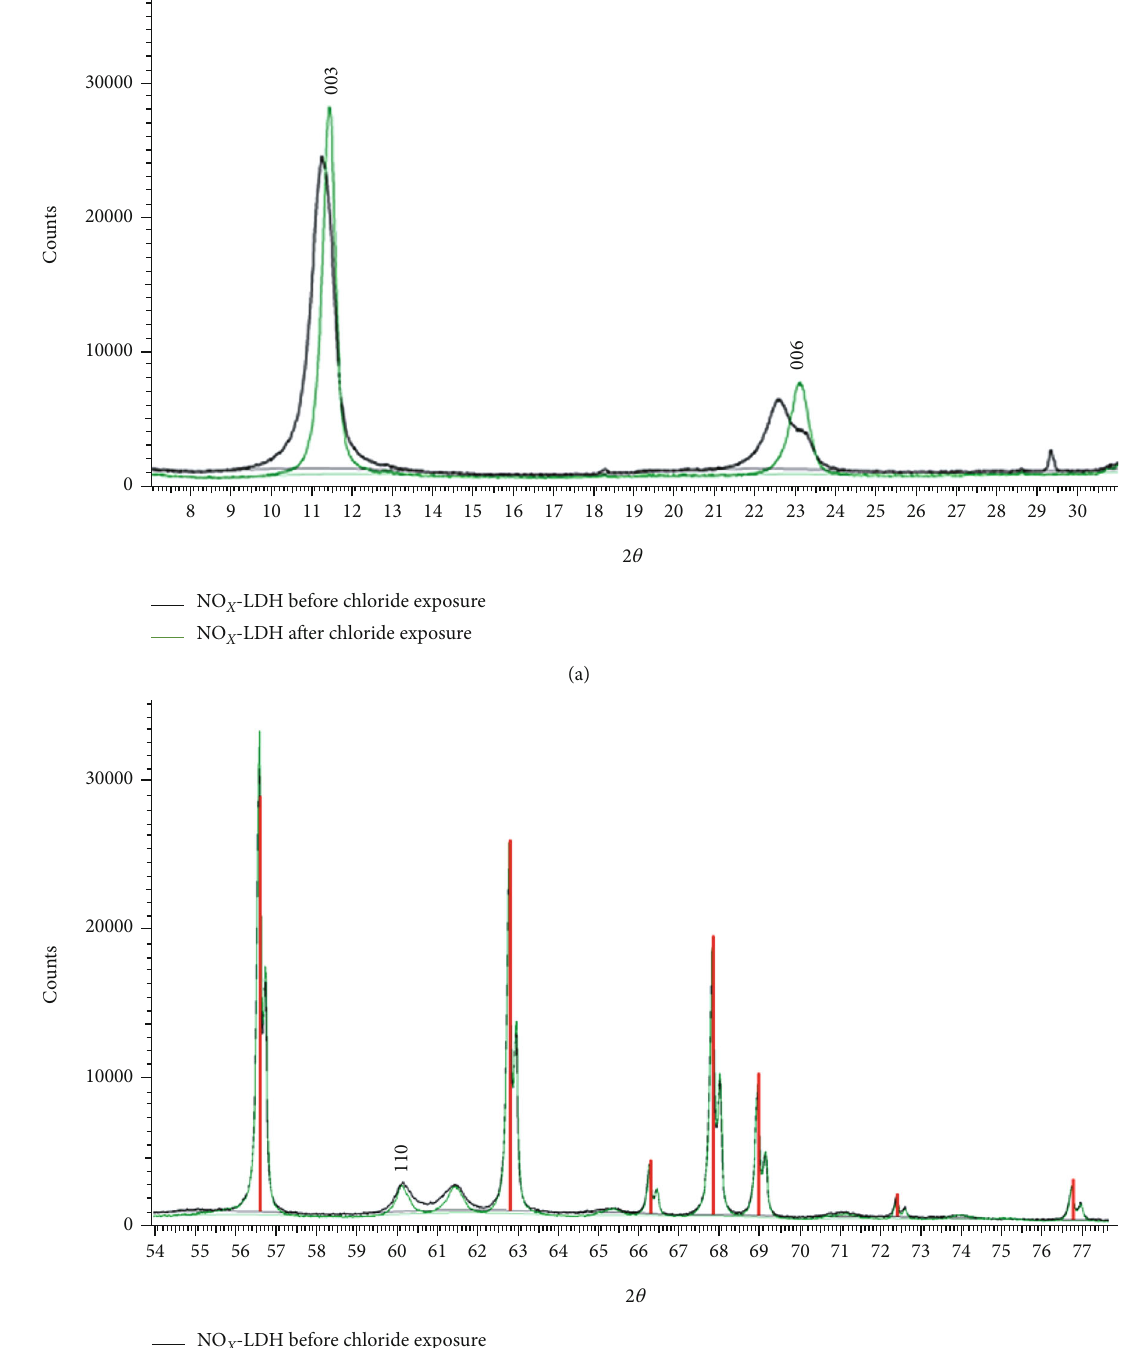
Figure 5: Di ff ractograms obtained for NO -LDH before (black) and after (green) exposure to 3.5% NaCl (a) region between 8 and 31 ° and (b) X region between 54 and 77 ° . Peaks assigned with red risk are related to the standard ZnO added to the sample to the correction of peak